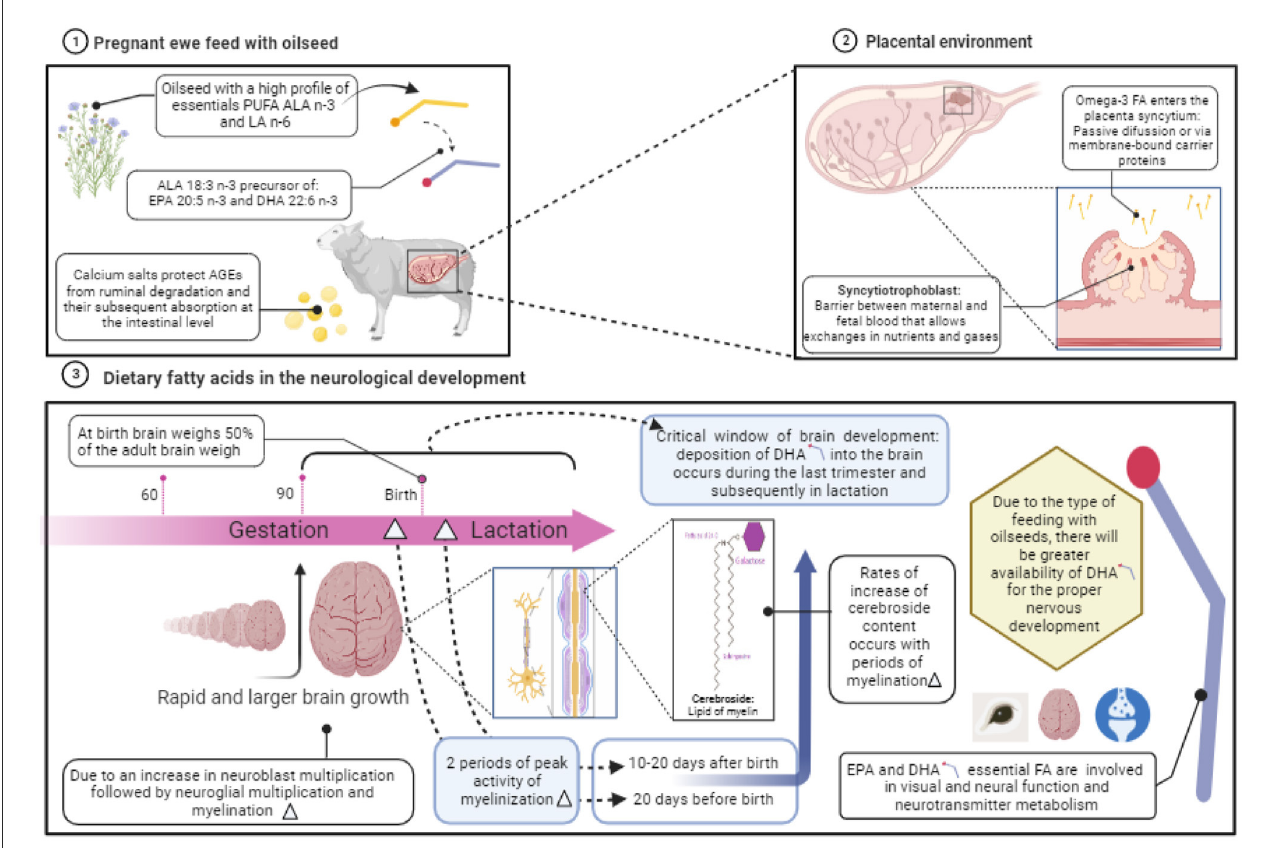
FIGURE3 Role of dietary fatty acids on the neurological development during gestation in sheep. Created with